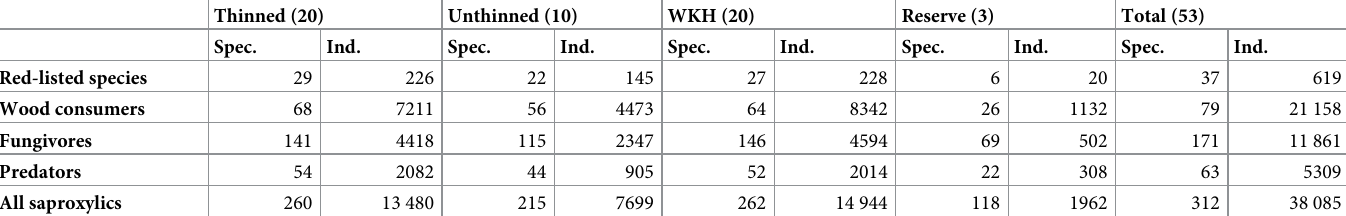
Table 2. Summary species data. Species (spec.) and individuals (ind.) per species group and forest type. The number of stands per forest type is given in parentheses. WKH = Woodland Key Habitat.